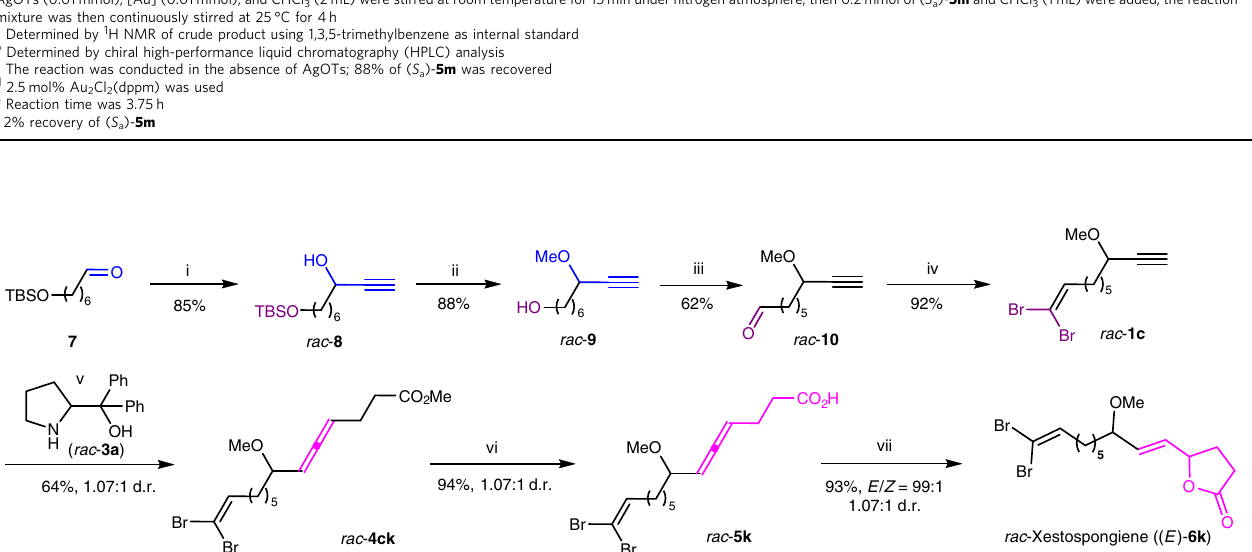
Fig. 5 First total synthesis of rac -xestospongiene. Reagents and conditions: i. ethynyl-magnesium bromide (1.7 equiv.), THF, rt, 12.5 h; ii. NaH (1.0 equiv.), THF, 0 °C, 0.5 h, then rt, 0.5 h; then MeI (1.2 equiv.), 0 °C, 2 min, then rt, 5 h; then HCl (aq., 3.0 M), 0 °C, then rt, 1.5 h; iii. Fe(NO 3 ) 3 ∙ 9H 2 O (8 mol%), TEMPO (8 mol%), NaCl (8 mol%), O 2 balloon, DCM, 25 °C, 12.5 h; iv. CBr 4 (1.5 equiv.), PPh 3 (3.0 equiv.), DCM, 0 °C, 0.5 h, then 0 °C ~ rt, 1 h; v. rac - 3a